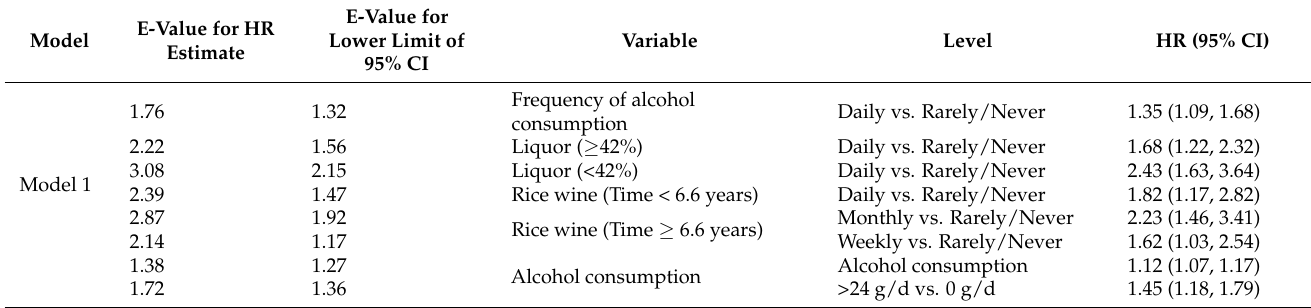
Table 6. E-values for the effect of drinking on hypertension (and its lower limit of 95% CI) in each adjusted Cox